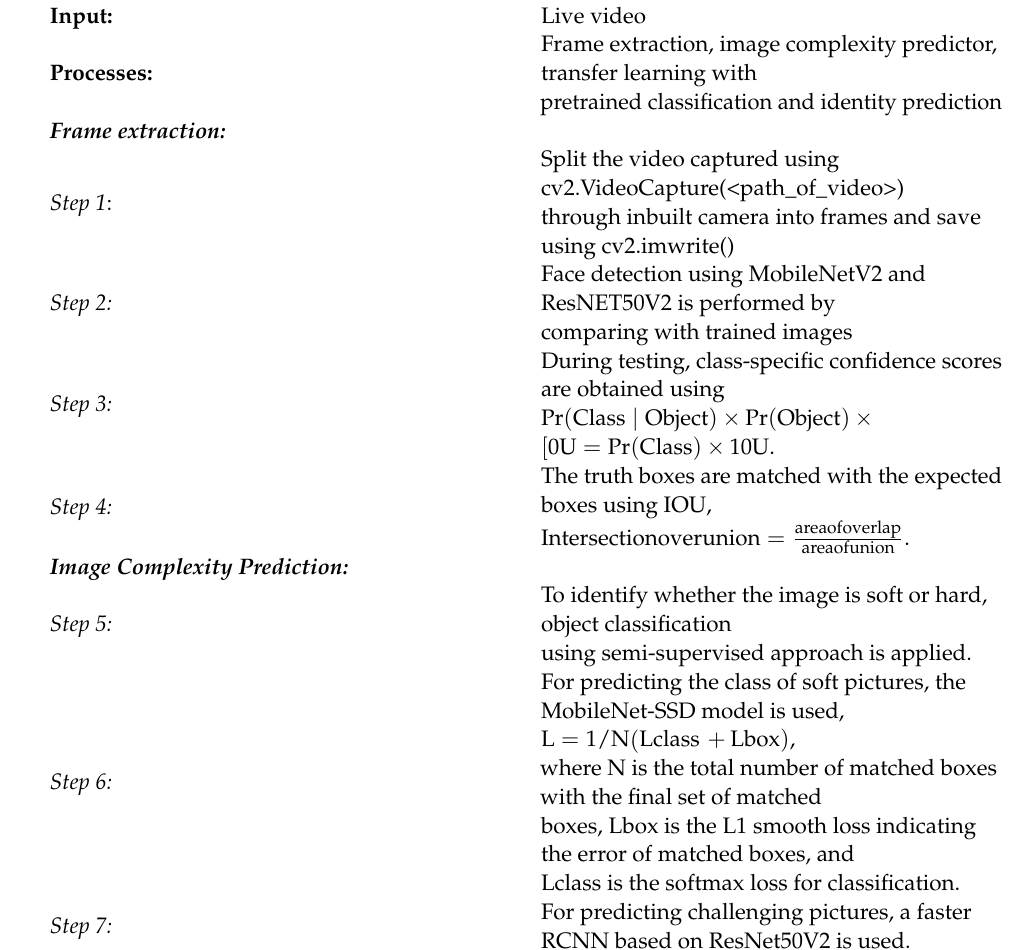
Algorithm 2. Deployment